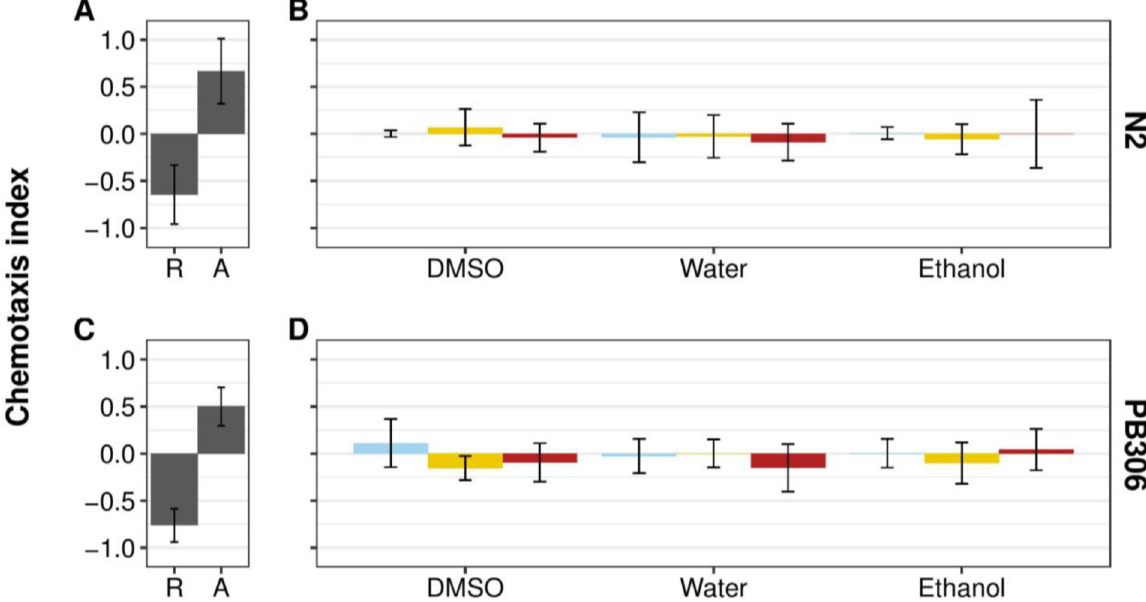
Fig 1. C . elegans strains N2 and PB306 adults do not respond to P . scaber washes with three solvents. (A) and (C) Plot of repulsive (R) and attractive (A) reference control chemotactic indices for the C . elegans N2 and PB306 strains. Undiluted 1-octanol was used as the repulsive negative control (left) and isoamyl alcohol diluted to 10 − 3 in ethanol was used as the attractive positive control (right). (B) and (D) Plot of chemotactic indices of N2 and PB306 adult C . elegans to undiluted P . scaber washes compared to neutral control references. Blue bars represent the neutral control of solvent alone. Yellow bars represent chemotactic indices to washes that were prepared from male isopods. Red bars represent chemotactic indices to washes that were prepared from female isopods. From left to right, each grouping of bars represents dimethyl sulfoxide (DMSO), deionized water, and ethanol washes (n = 40–50 animals per condition, per replicate). Error bars are standard deviation. No isopod wash was significantly different from its corresponding neutral control (see S5 Table for p values).